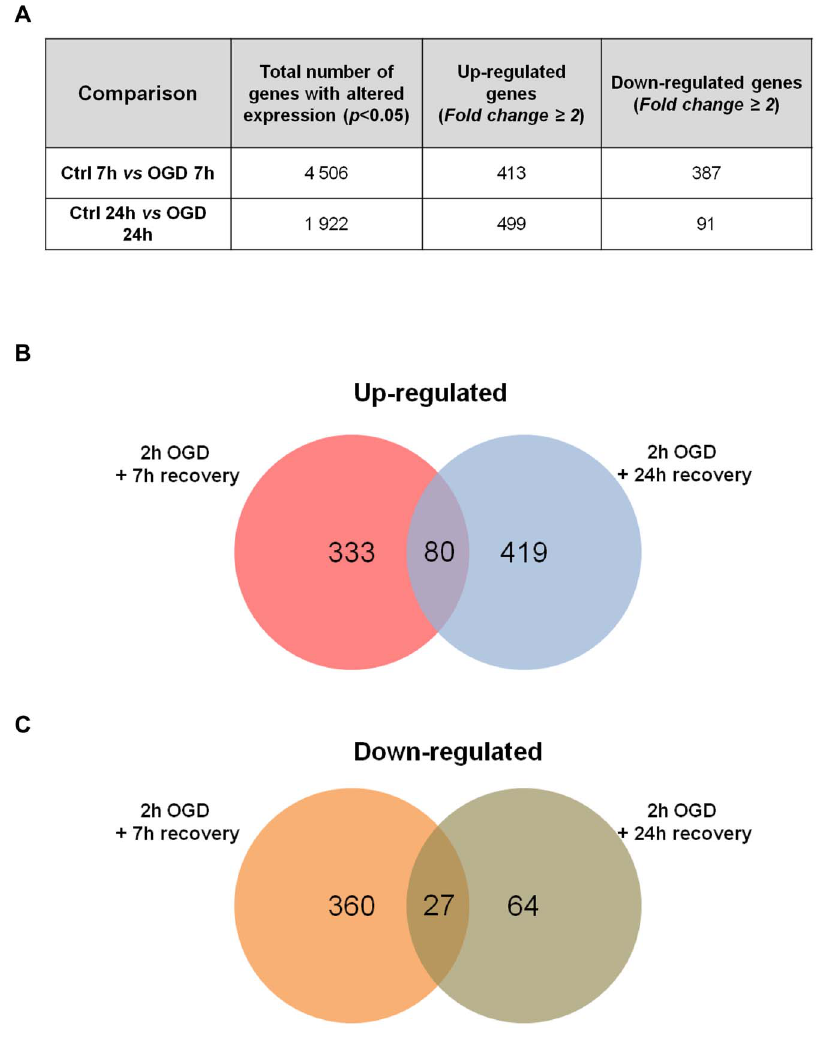
Figure 3. Summary of gene expression changes at 7 h and 24 h after OGD. ( A ) Student’s t -test analysis was applied to the microarray data to identify all genes whose expression was significantly different between conditions ( p , 0.05). Up-regulated and down-regulated genes include those whose expression levels had a fold change $ 2.0. ( B and C ) Number of up-regulated ( B ) or down-regulated ( C ) transcripts at 7 h and 24 h after 2 h OGD. The intersection represents the number of transcripts whose transcription was changed in both recovery periods. The transcripts used in this analysis were considered differentially expressed after using two cut-off criteria: a p -value , 0.05 and a fold change of 2.0. The VENNY informatic tool was used to compare the lists of transcripts to obtain the Venn